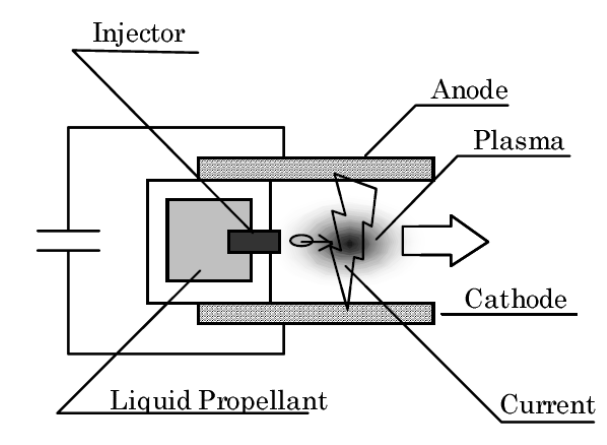
Figure 1. Operation of liquid propellant PPT